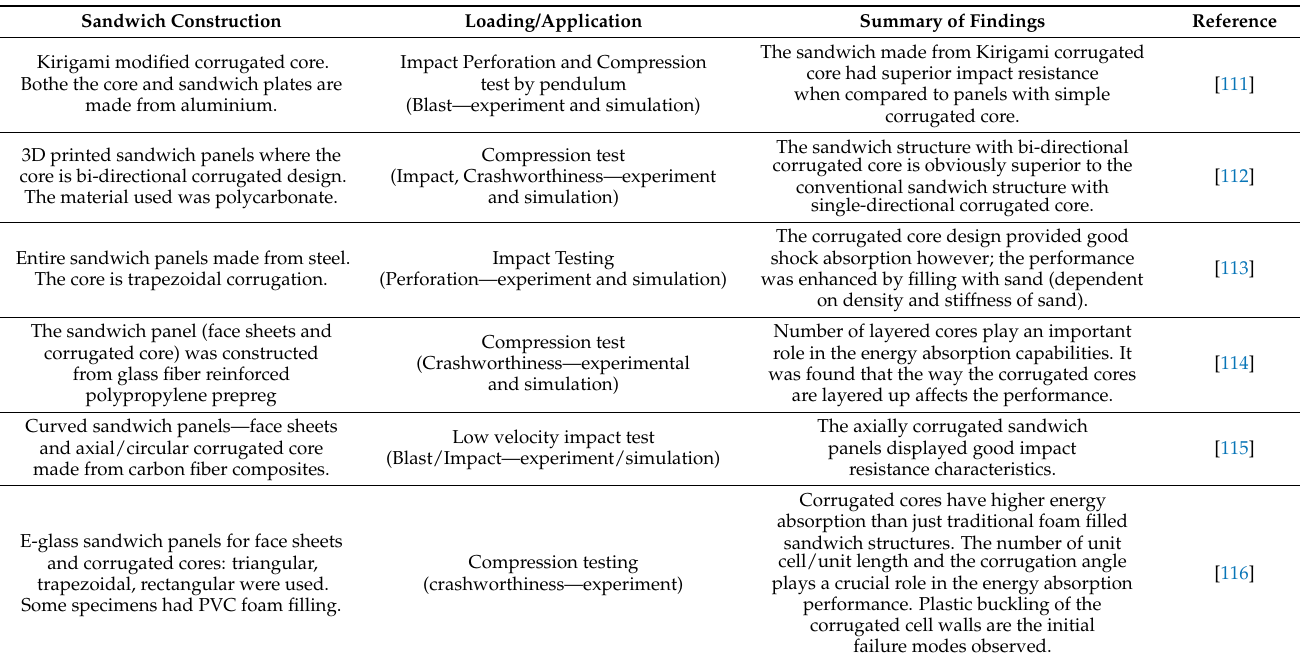
Table 8. Sandwich structure with corrugated